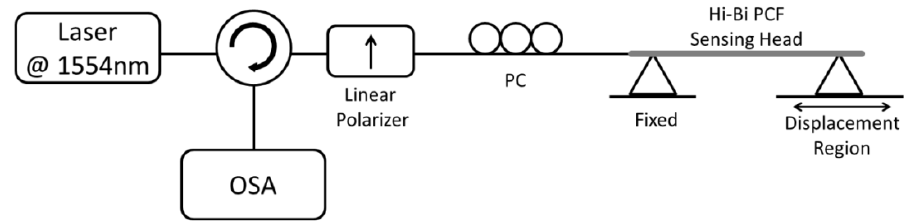
Figure 5. Experimental setup for strain measurement with an interferometric in-reflection Hi-Bi PCF sensing head.